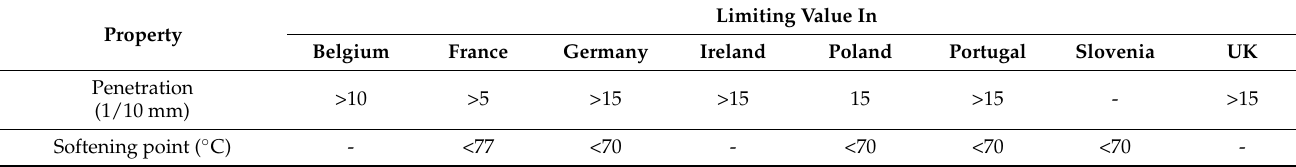
Table 1. Limiting Values of RAP Binder Properties for